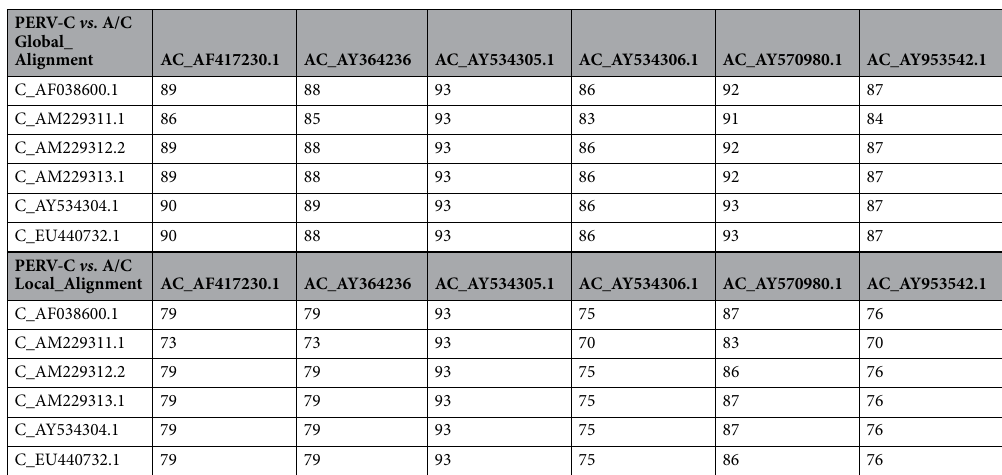
Table 3. Identity (%) between PERV-C and PERV-A/C by global and local alignments.